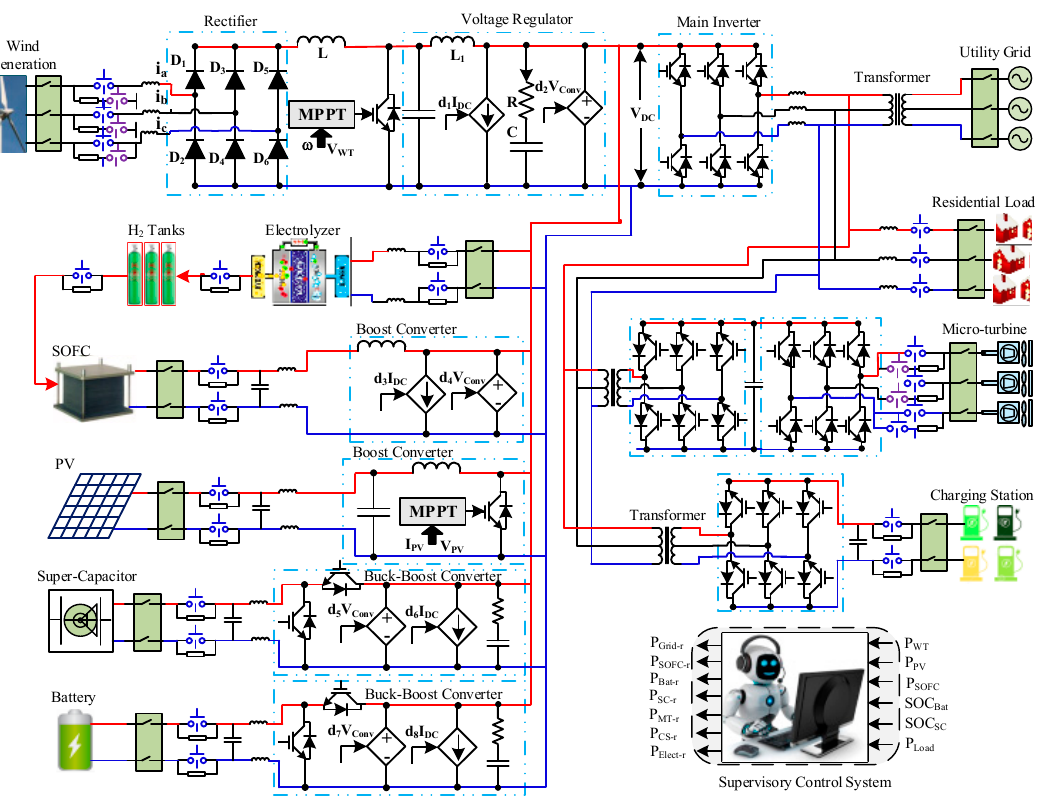
Figure 1. Hybrid renewable energy system.